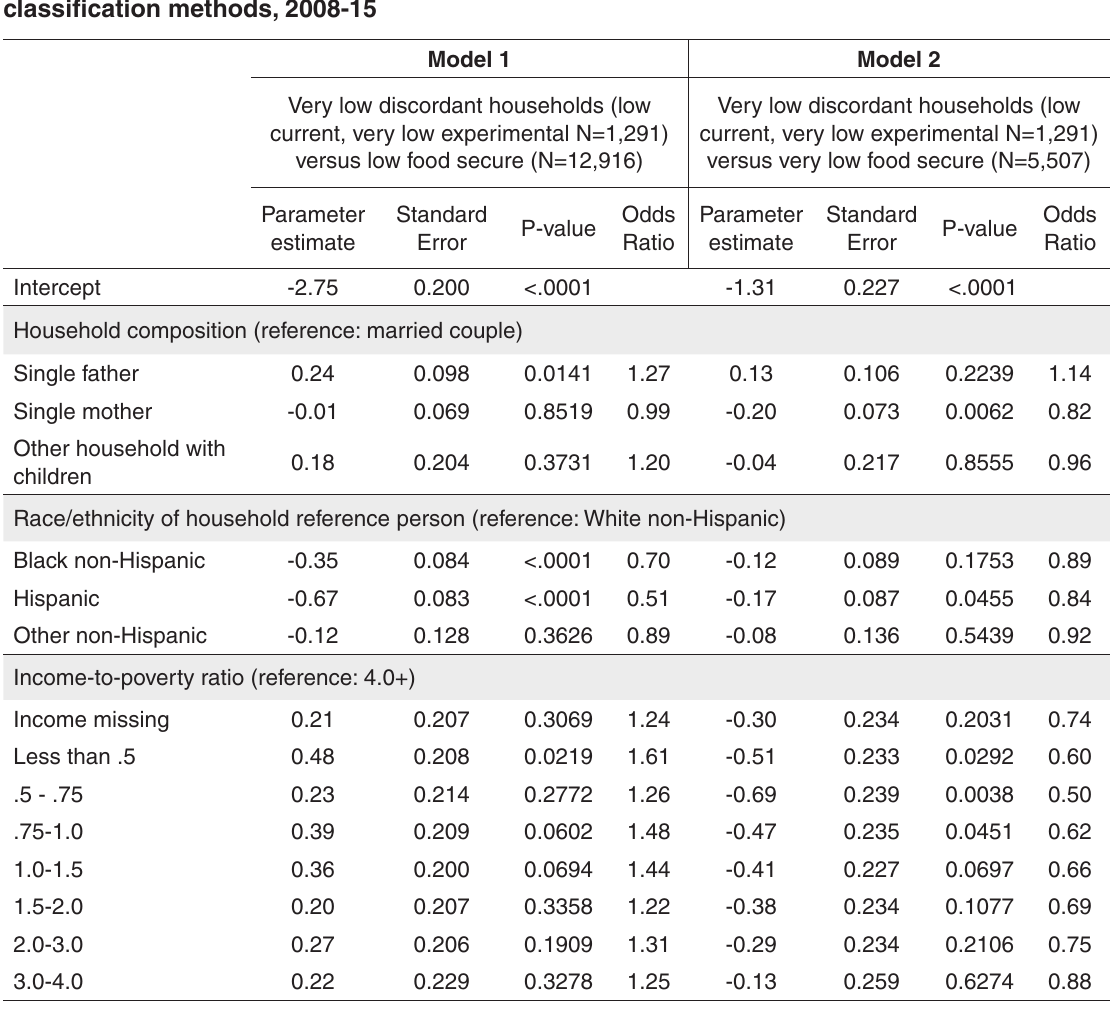
Logistic regression model comparing very-low-food-secure discordant households (low food secure current and very low food secure experimental) with households consistent on both classification methods,